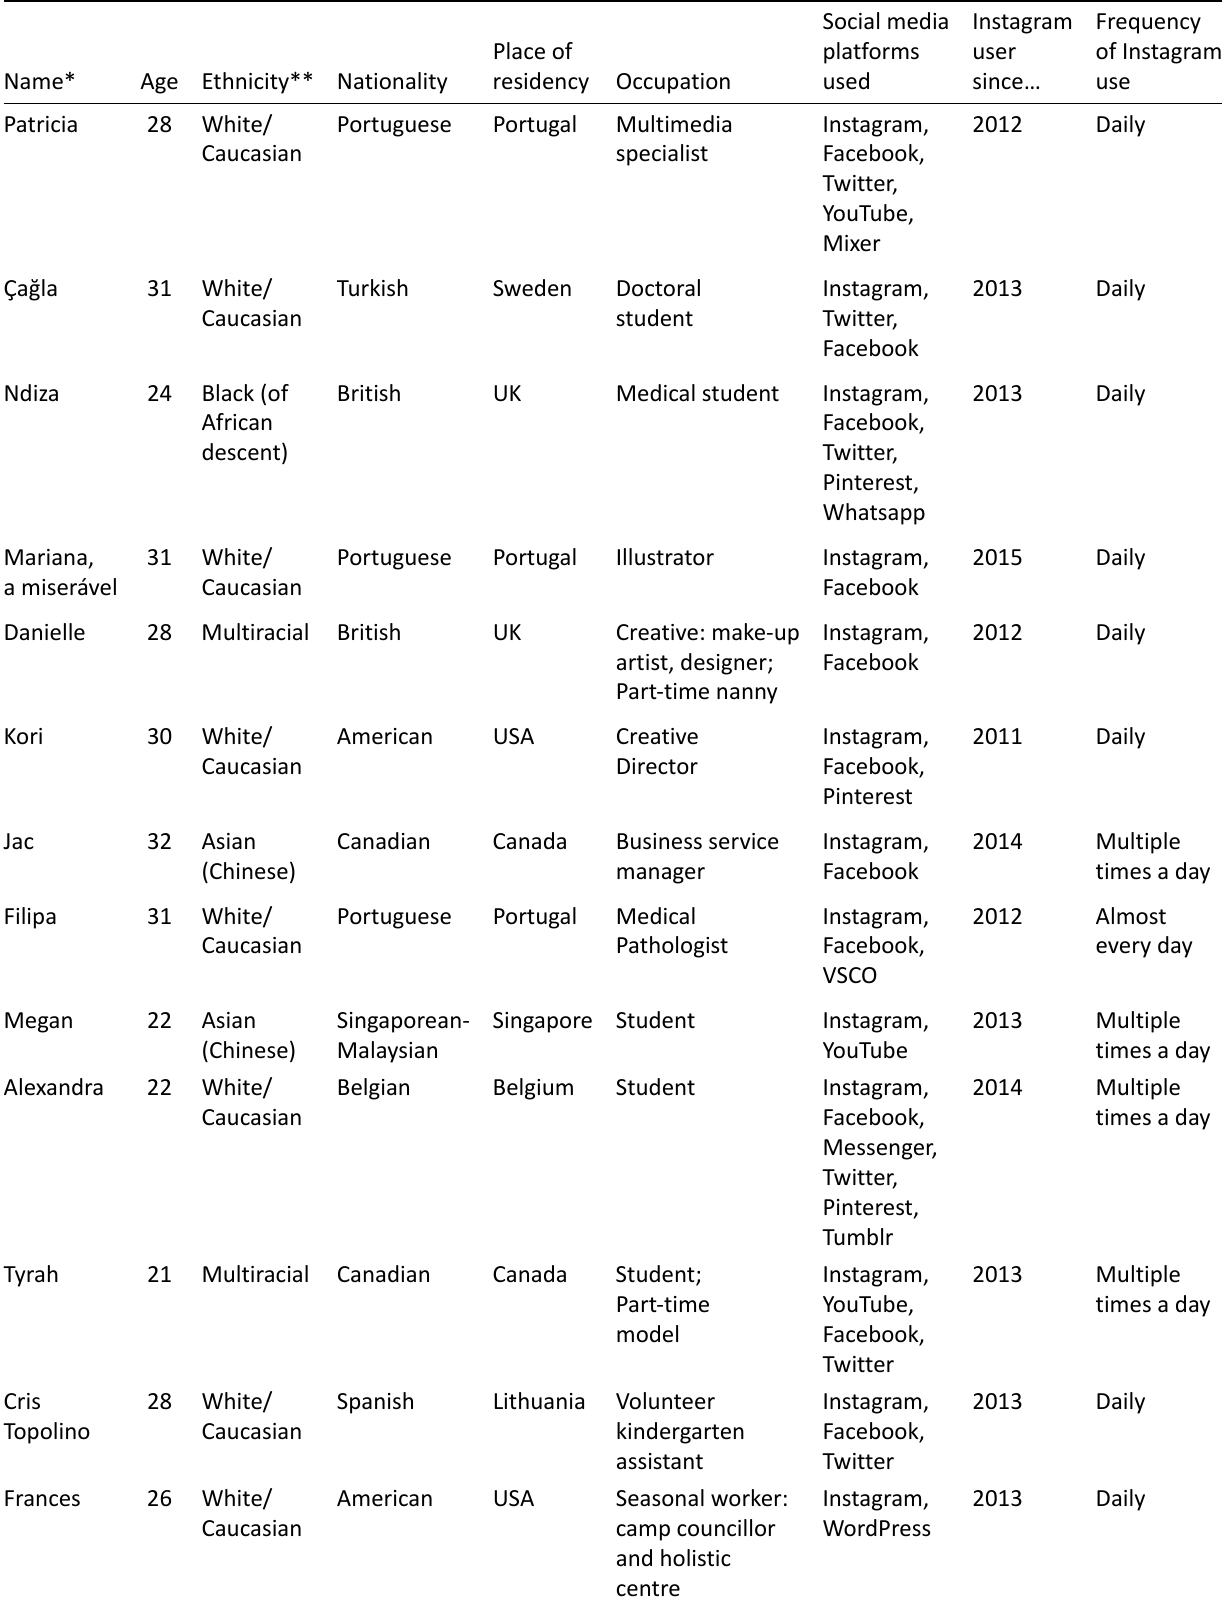
Table 1. Overview of the